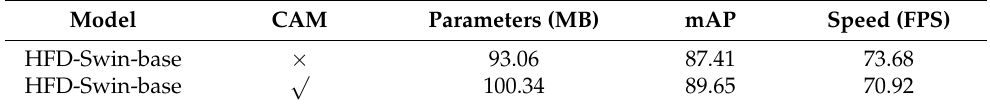
Table 3. The effectiveness of the combination attention module for HFD with